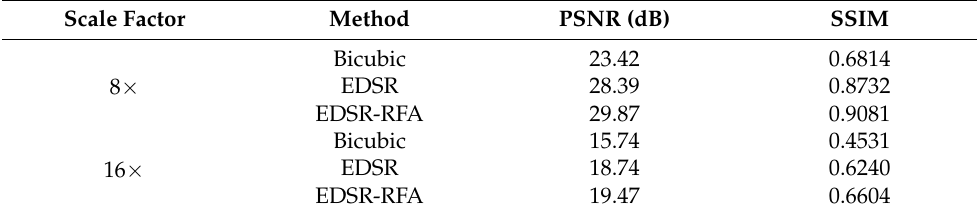
Table 2. Bicubic degradation result of super-resolution for downscaling factors of 8 and 16, indicating